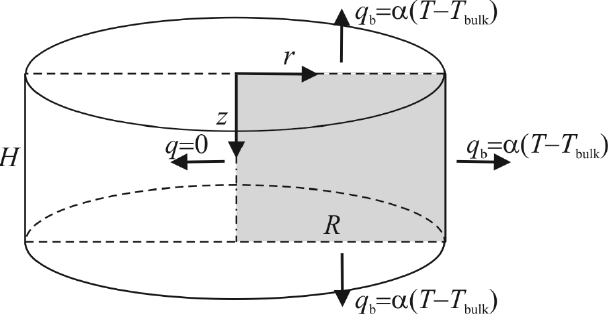
Figure 1. Domain considered and boundary conditions.